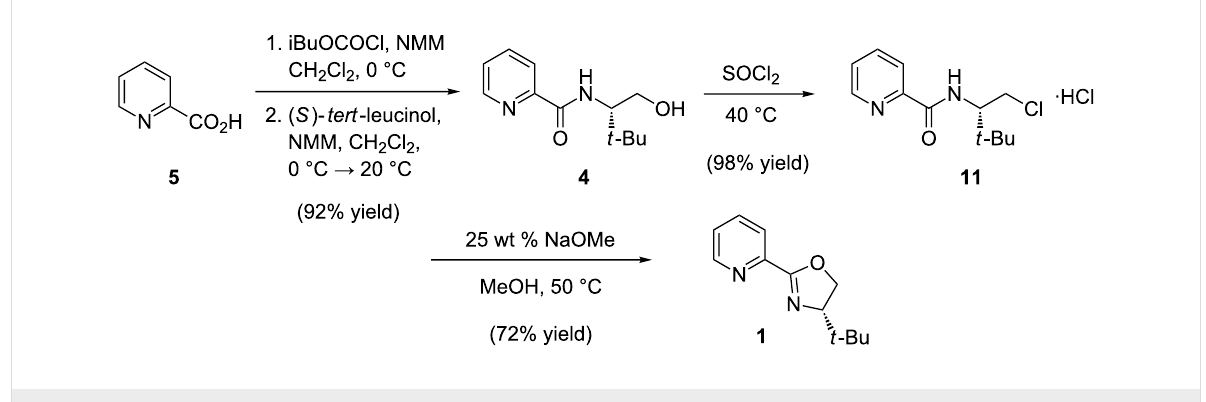
Figure 2: Scale-up synthesis of ( S )- t-